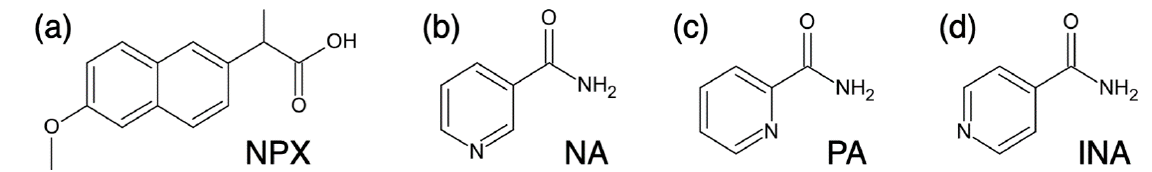
Figure 1. Molecular structures of ( a ) naproxen (NPX), ( b ) nicotinamide (NA), ( c ) picolinamide (PA), and ( d ) isonicotinamide (INA).